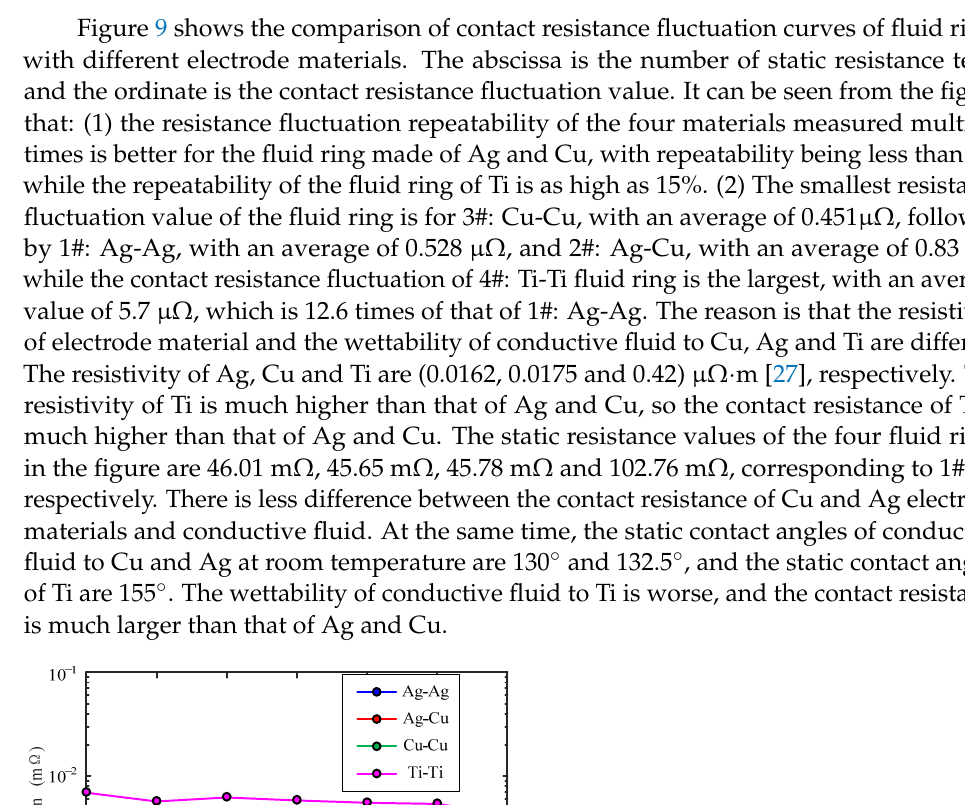
Figure 8. Static contact resistance and resistance fluctuation variations with temperature.